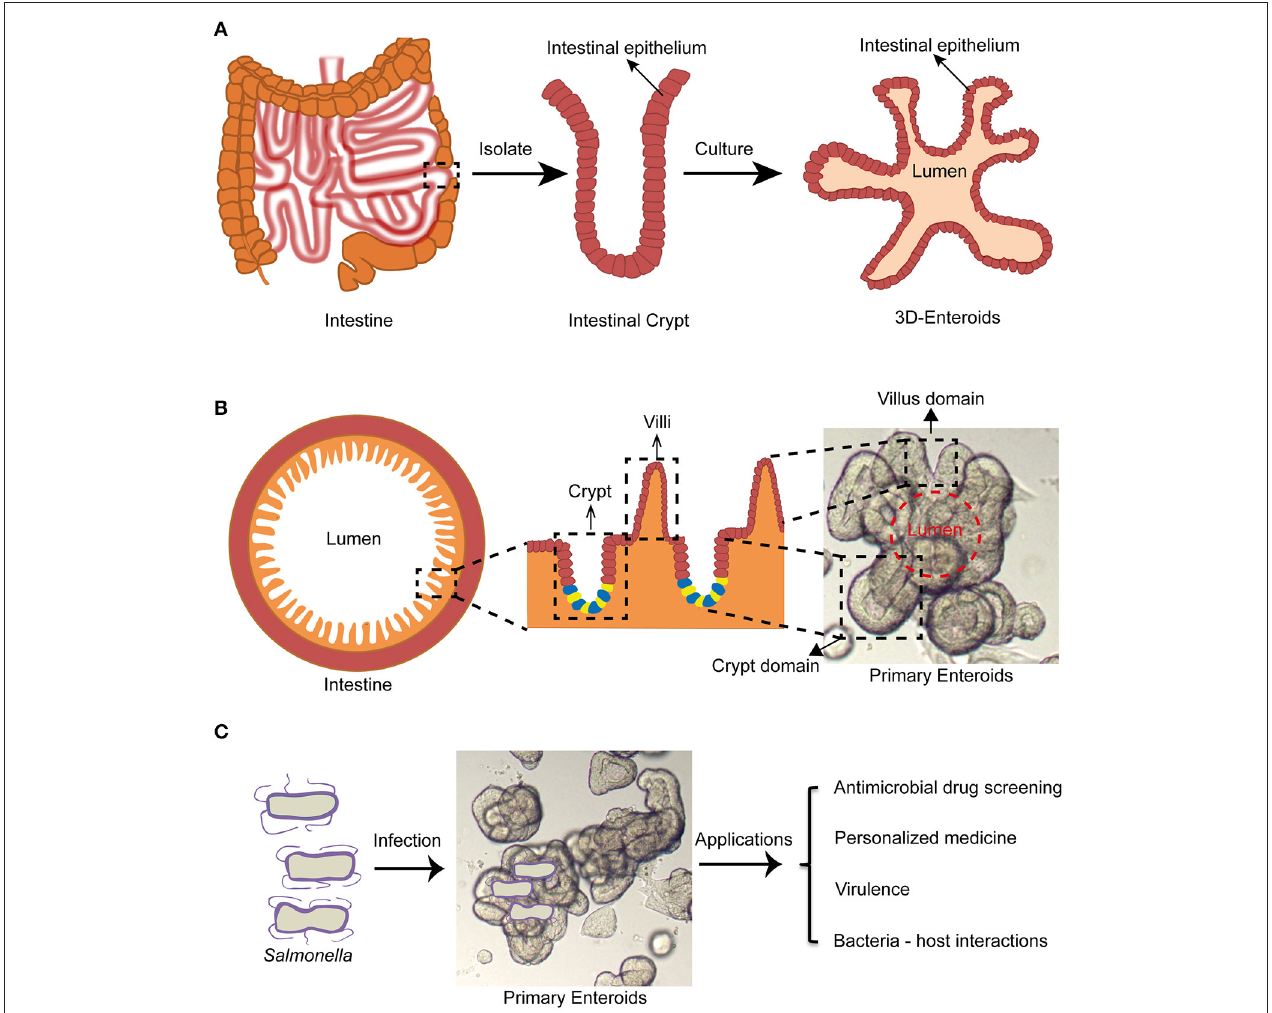
FIGURE 1 | Enteroid model and its potential application in studying Salmonella infections. (A) Intestinal crypts can be isolated from surgery sections or biopsies, followed by culturing into 3-D enteroids. (B) Enteroids recapitulate architectures of healthy intestine containing villus and crypt domains. (C) Enteroids may be a promising experimental model for studying Salmonella infections for antimicrobial drug screening, personalized medicine, virulence mechanisms and bacterial-host interactions.